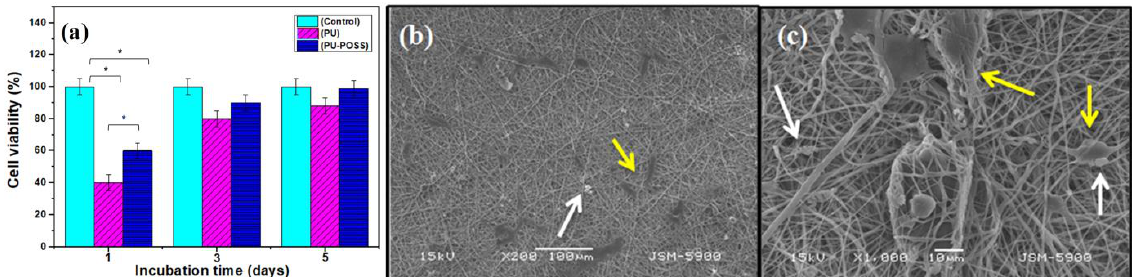
Figure 6. Cell counting assay-8 data ( a ) variability of control was positioned at 100%, and viability reference to control was articulated. At day one of incubation, significant differences (* p ≤ 0.05) in cellular response were observed on PU and POSS-grafted PU. However, a less significant difference was observed with an increase in time on both the nanomatrices with respect to the untreated control. The experiment was performed at least in triplicates, and divergence was considered statistically significant at a value of * p ≤ 0.05. Statistical computations were run on SPSS statistical software by an unpaired Student’s t -test. Illustrative SEM images ( b , c ) point to propagation on POSS-grafted PU nanomatrix. Yellow arrows point to myoblasts and white arrows POSS